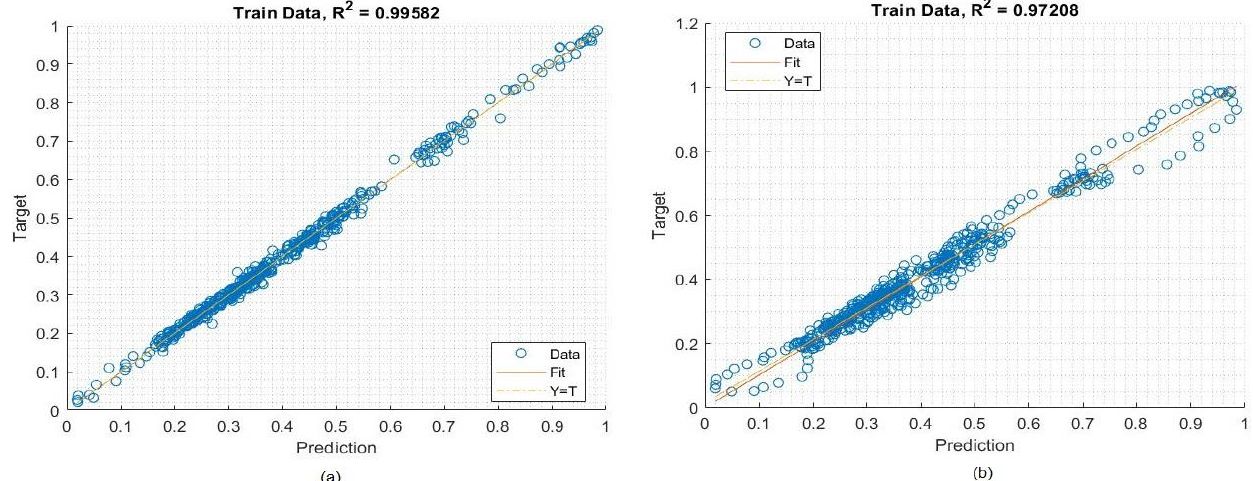
Figure 16. Squared regression plot of the deep learning models ( a ) CNN-LSTM and ( b ) LSTM during the training phase for Tesla.